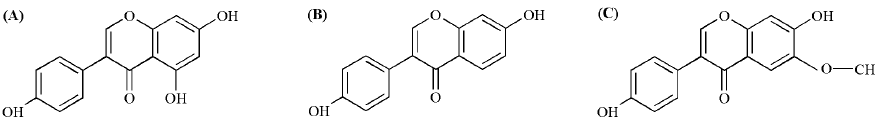
Figure 1. Chemical structures of soy aglycones: ( A ) genistein; ( B ) daidzein; ( C ) glycitein.